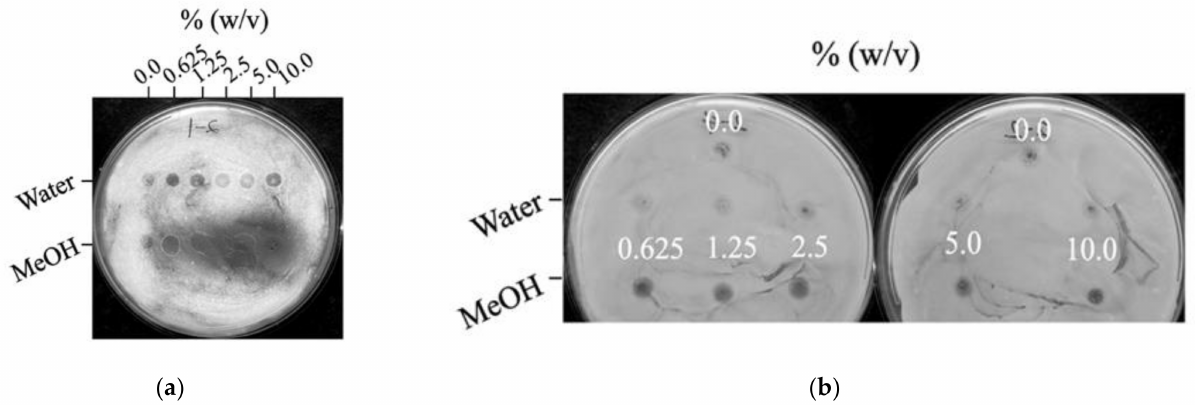
Figure 1. Antifungal activity of methanol extracts of T. camphoratus (TcM) (0.625% to 10.0%). ( a ) Incremental increase of TcM activity against A. fumigatus AF293, proportional to the TcM con- centrations. ( b ) A steady antifungal activity of TcM against C. albicans ATCC 10231. Note that no antifungal activity was detected with water extracts of T. camphoratus